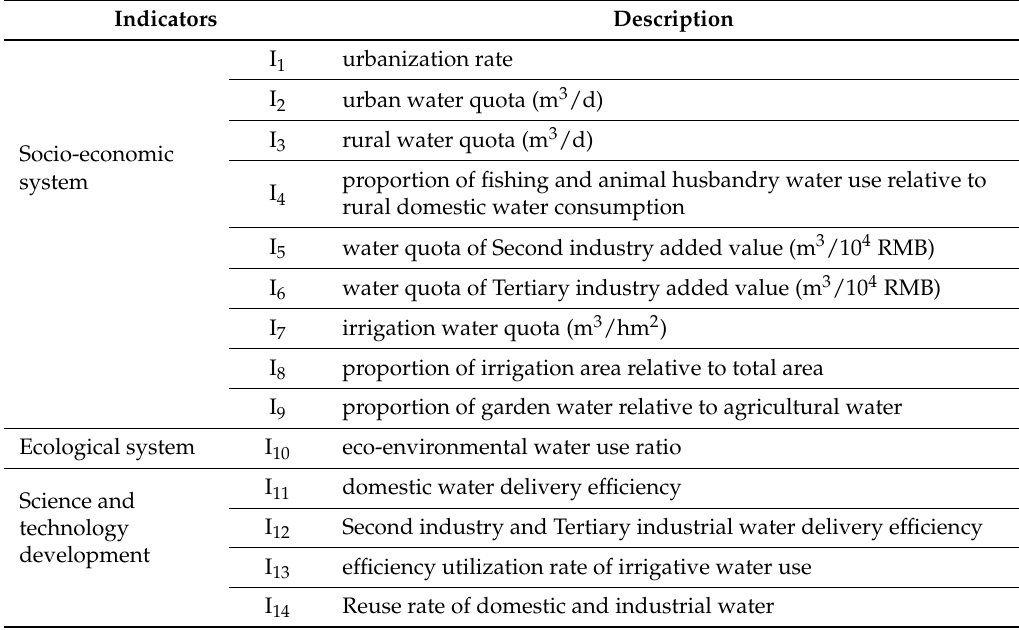
Table 3. Indicators for water resources design carrying capacity.